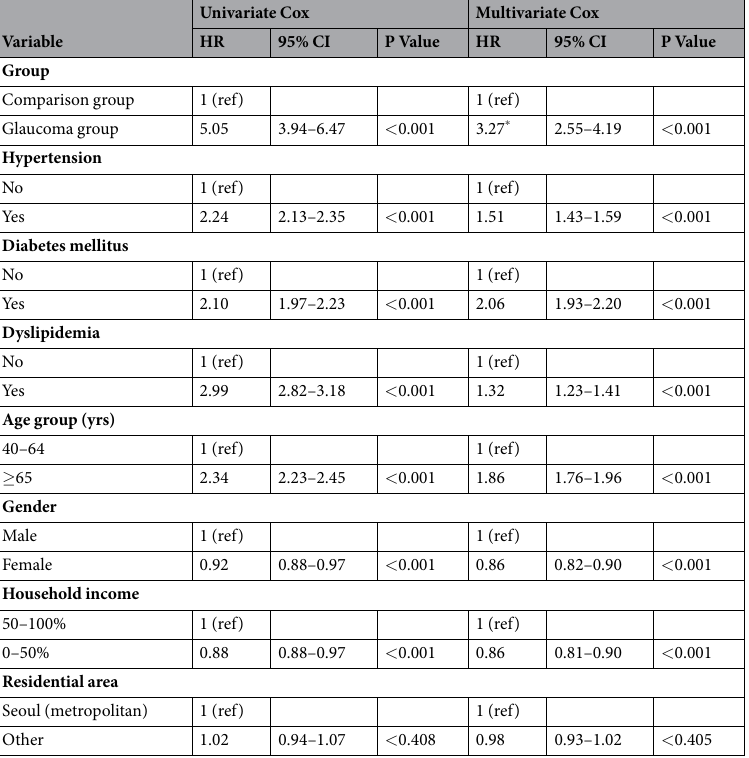
Table 4. Univariate and multivariate cox regression analysis for development of retinal vein occlusion after glaucoma during an eleven-year follow-up period. HR = hazard ratio, CI = confidence intervals. * Adjusted for age, gender, income, residential area, hypertension, diabetes mellitus,